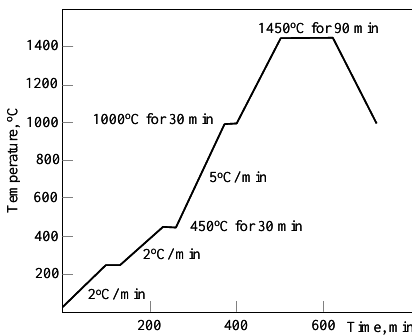
Figure 2. ( a ) Schematic drawing of the cold-compaction assembly. ( b ) 3D and 2D drawings of the rectangular die. All dimensions in ( b ) are in mm.